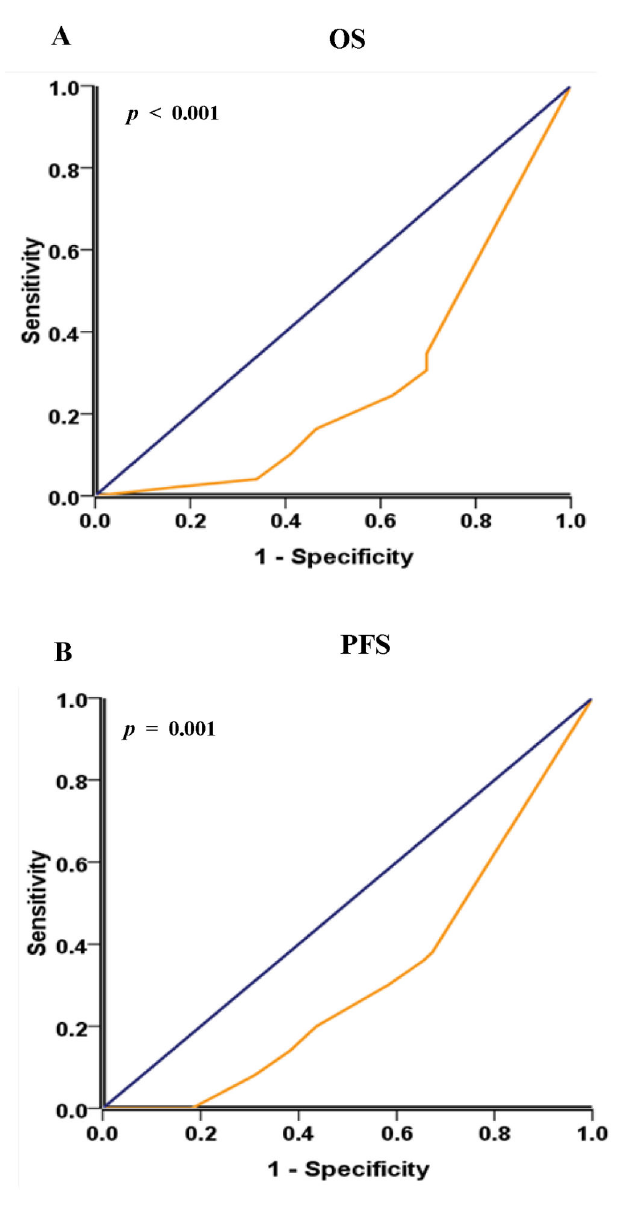
Figure 2. ROC curves analysis of Beclin 1 cutoff score. (A) and (B) showed the Beclin 1 cutoff points for overall survival and progression-free survival in the training set. At each immunohistochemical score, the sensitivity and specificity for the outcome being studied was plotted, thus generating a ROC curve. The cutoff point of Beclin 1 for overall survival and progression-free survival was 2.7 and 2.9